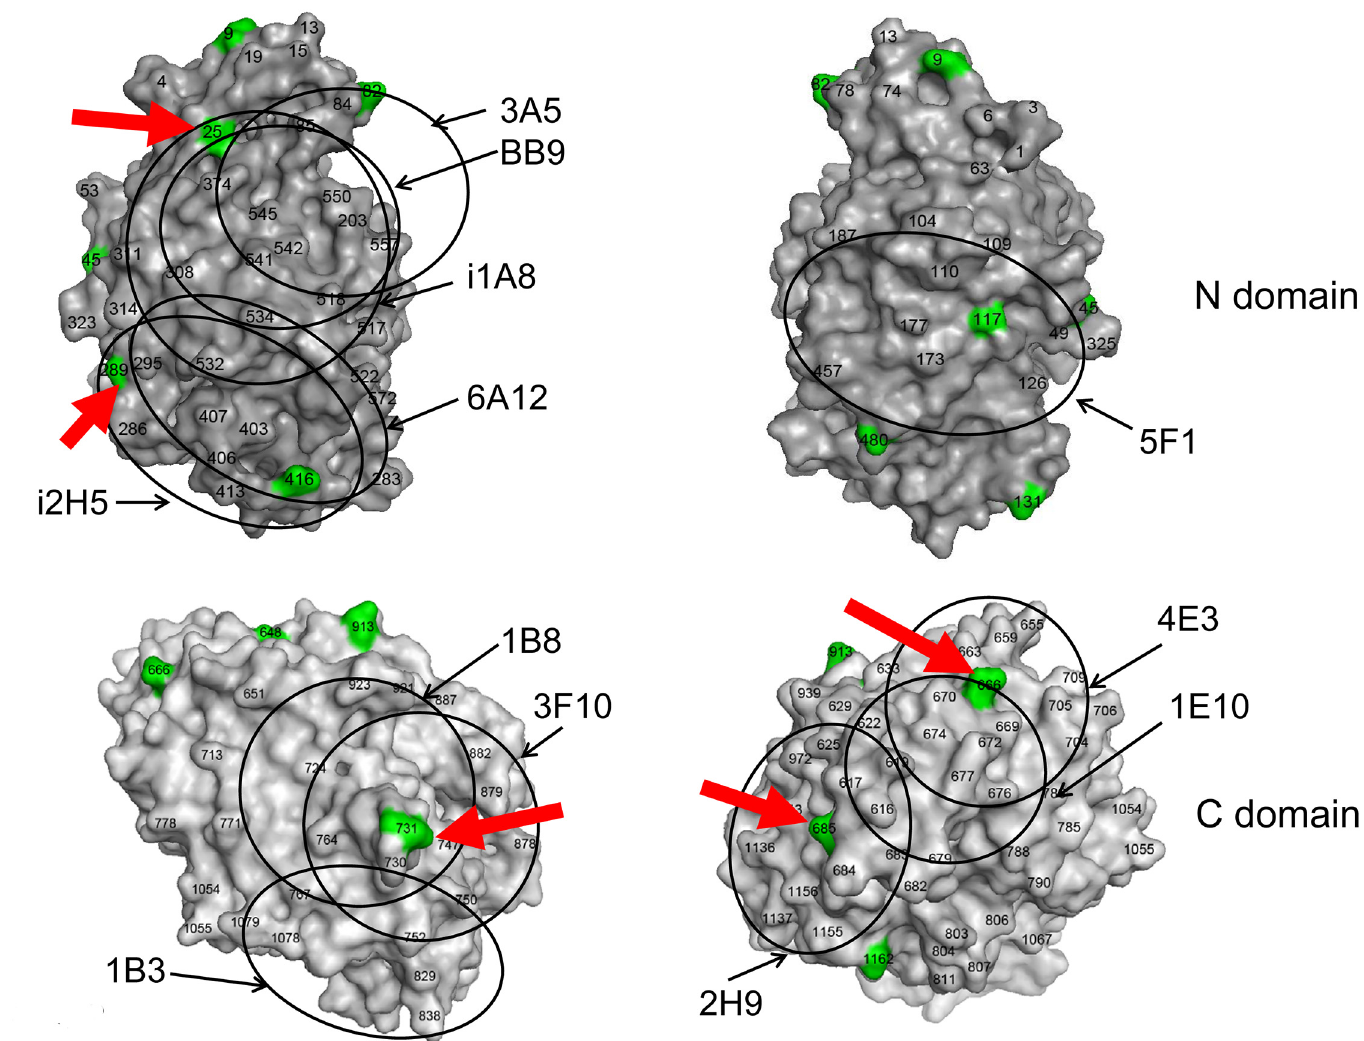
Fig 3. The structures of N and C domains of ACE with potential glycosylation sites and epitopes for mAbs. Human N domain structure was based on PDB P2C6N and C domain structure — based on PDB 1O86. The epitopes were marked on the N and C domains according to [27 – 31, 41]. The positions of the epitopes for some mAbs (12 out of 17) are shown by circles on both sides of domain globule. The potential sites of N-glycosylation, 9 on the N domain and 6 on the C domain, are marked by green; Asn494 on the N domain is not seen while Asn1196 is not present in structure of the C domain. The glycosylation sites which might be differently glycosylated in seminal fluid ACE and lung ACE are shown by arrows. Some amino acid residues are shown by numbers according to [38] for